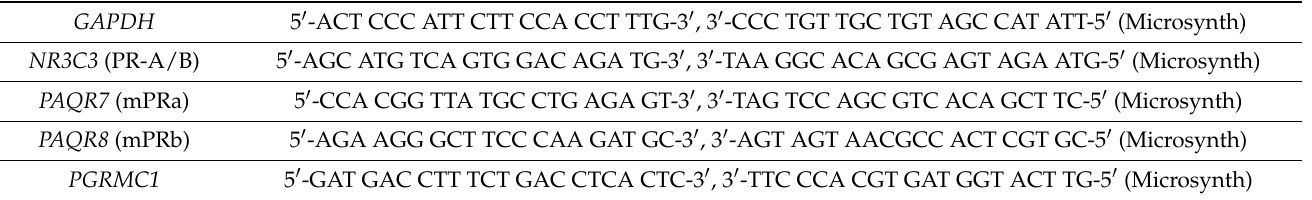
Table 1. Used primers for quantitative real-time